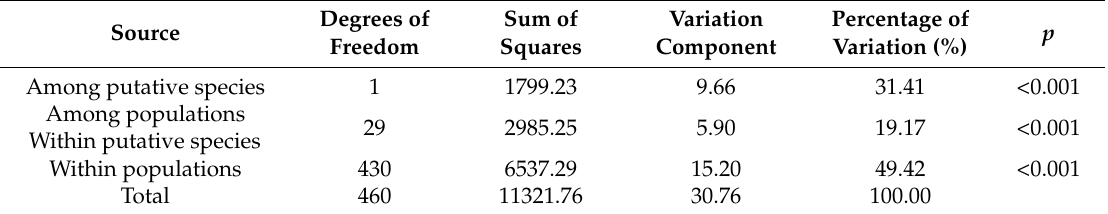
Table 5. Analysis of molecular variance (AMOVA) of 31 Melia populations.